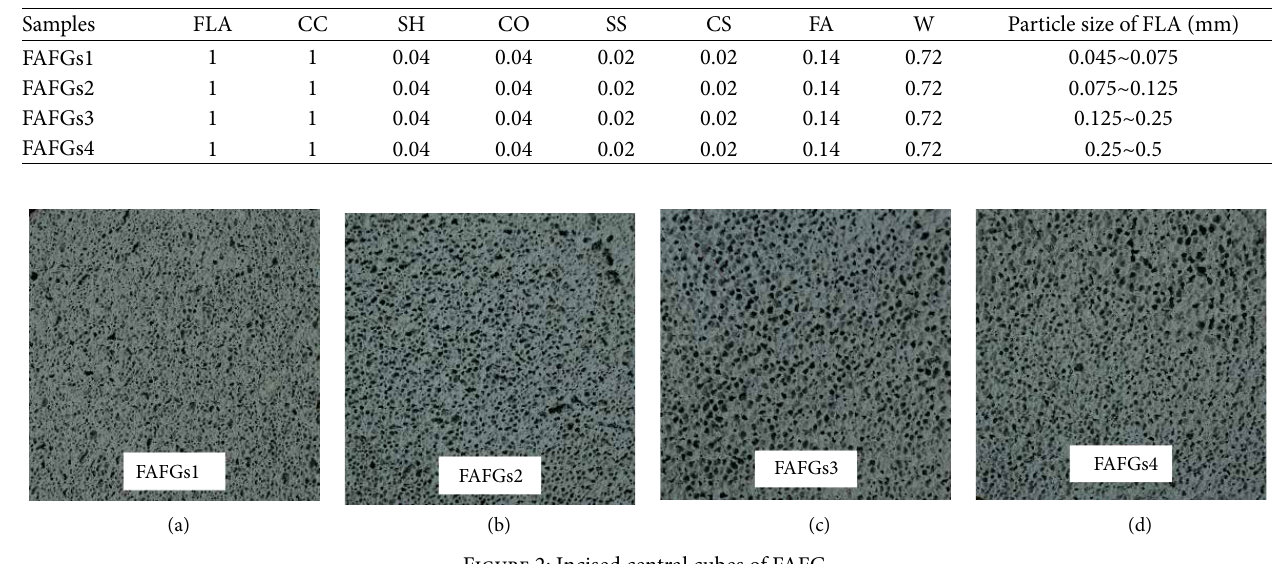
Table 3: Mix proportion of raw material for FAFG (kg/batch).